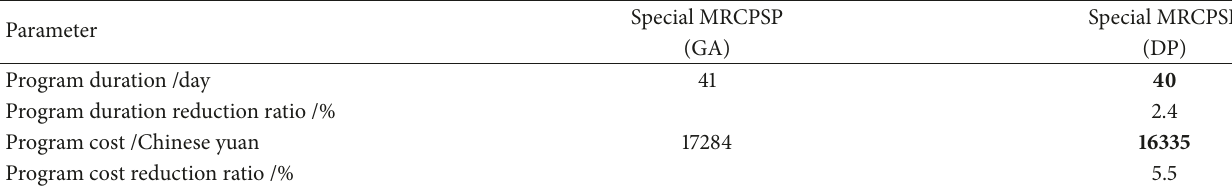
Table 11: Comparison of the best results obtained by GA and DP for solving special MRCPSP (real-life